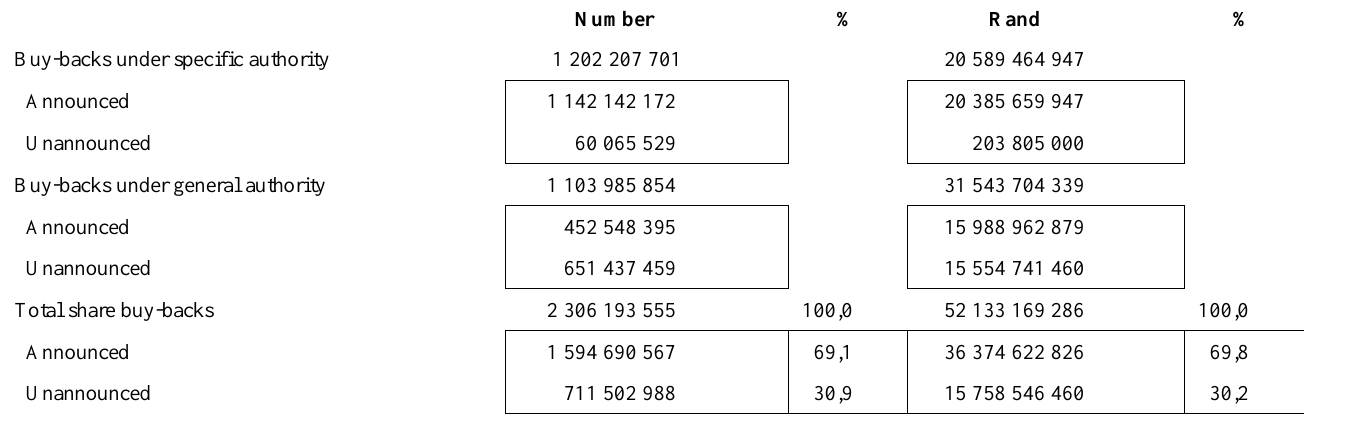
Table 6: Share buy-backs: purchases and sales Number % Rand